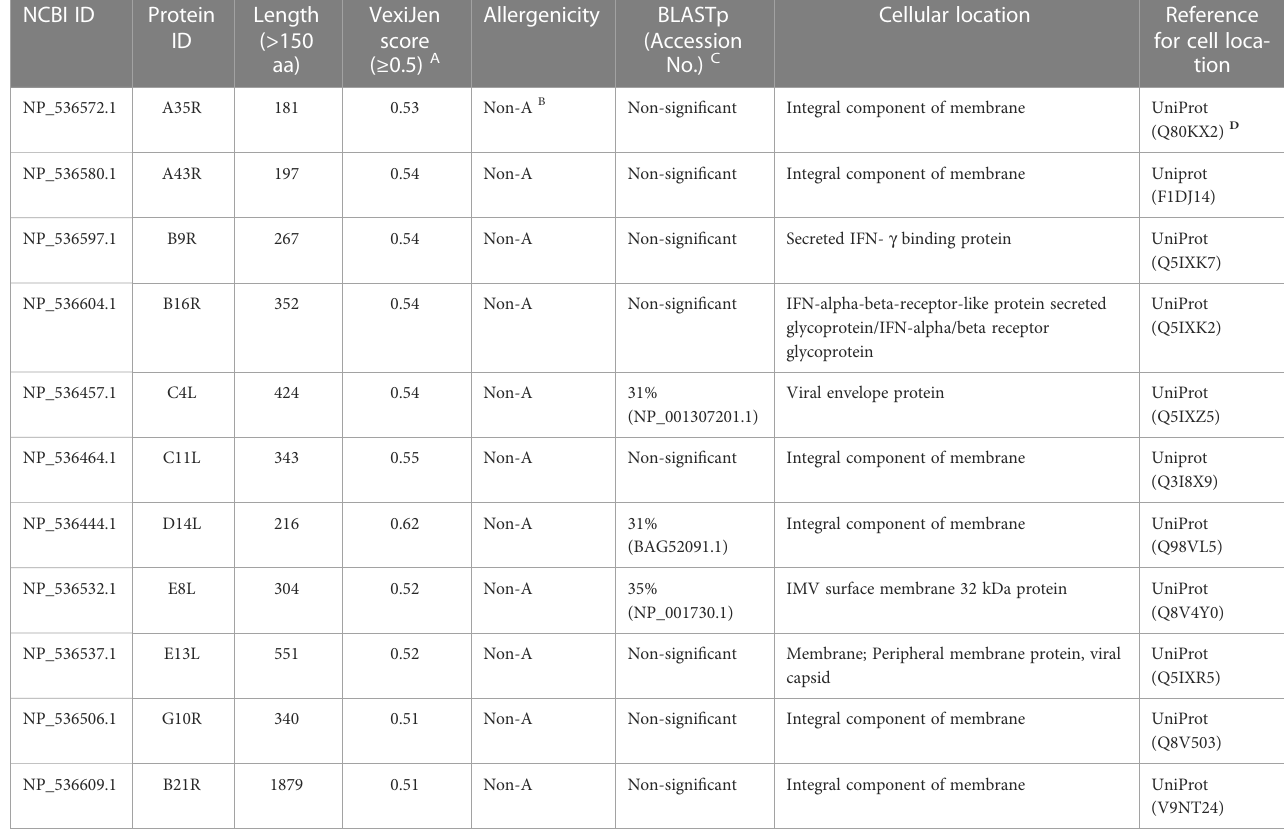
TABLE 1 Final candidate proteins of MPXV selected for epitope